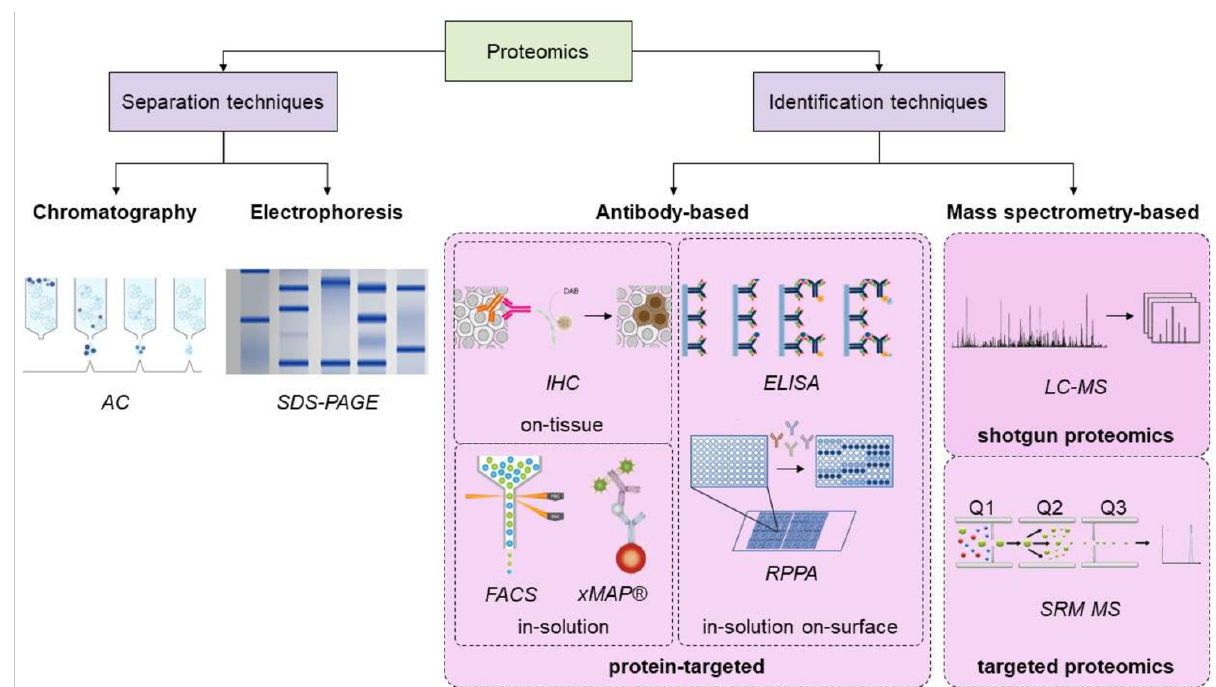
Figure 5. Schematic representation of proteomics techniques. Separation techniques are usually employed in the preparative steps for simplifying the complexity of the proteome. AC (affinity chromatography) is based on the differential adsorption of protein onto the surface and SDS-PAGE (sodium dodecyl sulfate-polyacrylamide gel electrophoresis) relies on the motion of proteins under the influence of an electric field. Antibody-based techniques identify proteins while maintaining the cell/tissue integrity, such as IHC (immunohistochemistry), FACS (fluorescence-activated cell sorting) flow cytometry or xMAP (multi-analyte profiling), or losing it, such as ELISA (enzyme-linked immunosorbent assay) or RPPA (reverse-phase protein assay). Mass spectrometry-based techniques cope with a higher number of proteins than antibody-based techniques and can be classified as shotgun proteomics when the objective is to identification, with the possibility of quantification them, such as LC-MS (liquid chromatography-mass spectrometry), or targeted proteomics, whether the purpose is to accurately quantify the expression levels of a set of proteins, such as SRM MS (single reaction monitoring mass